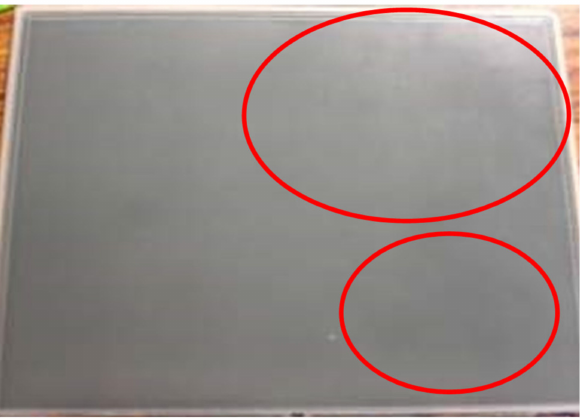
Figure 1. A TFT-LCD display with color streaks.